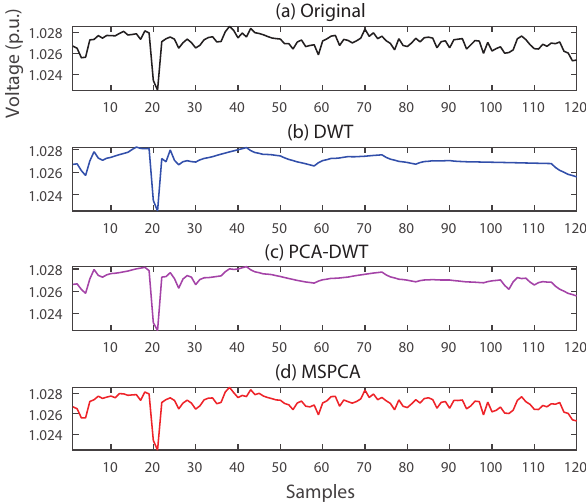
Figure 9. Comparison of reconstructed voltage signals. ( a ) Original data, ( b ) discrete wavelet transform (DWT), ( c ) PCA (principal component analysis)–DWT, ( d ) MSPCA (multiscale principal component analysis).